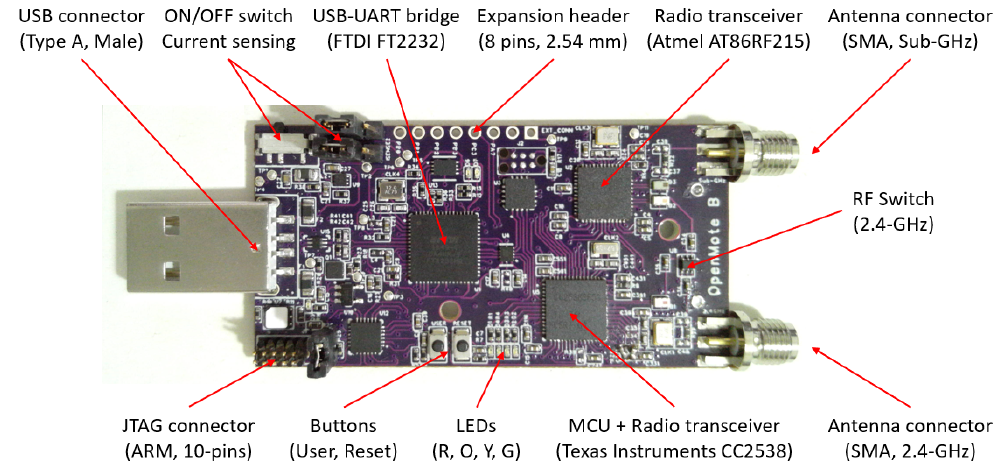
Figure 4. OpenMote-B board. The CC2538 (MCU) and the AT86RF215 (radio transceiver) are interconnected using the SPI bus, whereas the CC2538 (MCU) is connected to the computer using the USB-UART bridge (FTDI